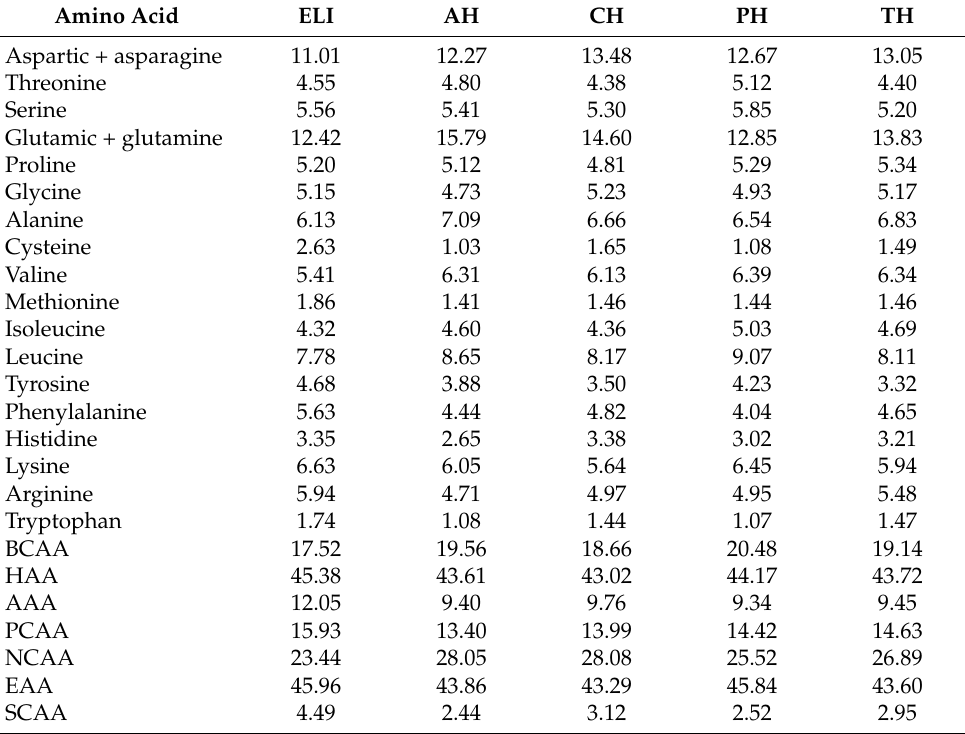
peptides when compared to AH and CH. The trypsin and pepsin hydrolysates shared two (GFK and HAGT) similar peptides but generally longer peptides were present in the TH. Table 1. Amino acid composition (%) of eggplant leaf protein isolate and enzymatic protein hydrolysates *.